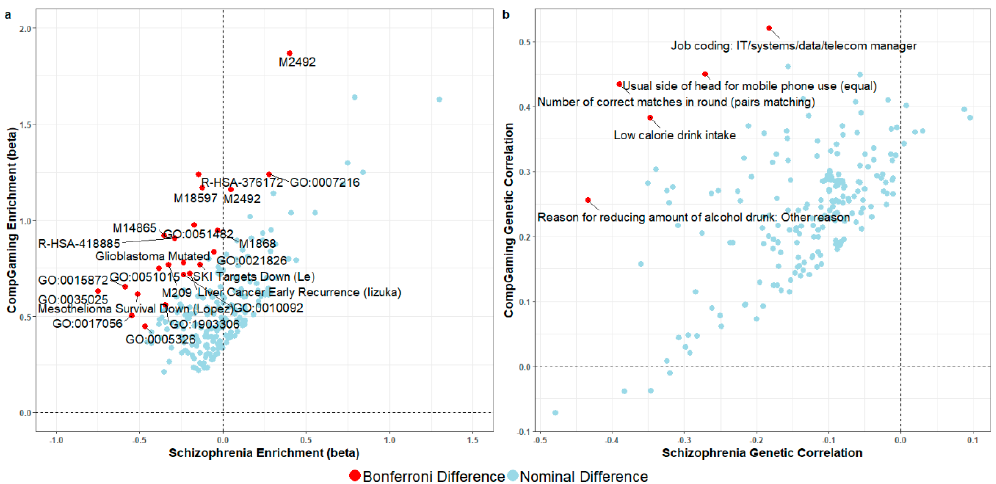
Figure 3. Scatterplots showing gene set enrichment ( a ; N = 221 gene sets) and linkage disequilibrium score regression ( b ; N = 224 traits) results for gene sets and UK Biobank traits with nominally significant di ff erences between schizophrenia and CompGaming (UKB Field ID 2237 “ plays computer games ”). Gene sets are labeled with gene ontology (GO), reactome (R), systematic identifiers (M), or specific study identifiers (last name of first author); the top five most significant di ff erences in genetic correlation are labeled. Detailed results for gene set enrichment and genetic correlations surviving multiple testing correction are provided in Tables S7S10.